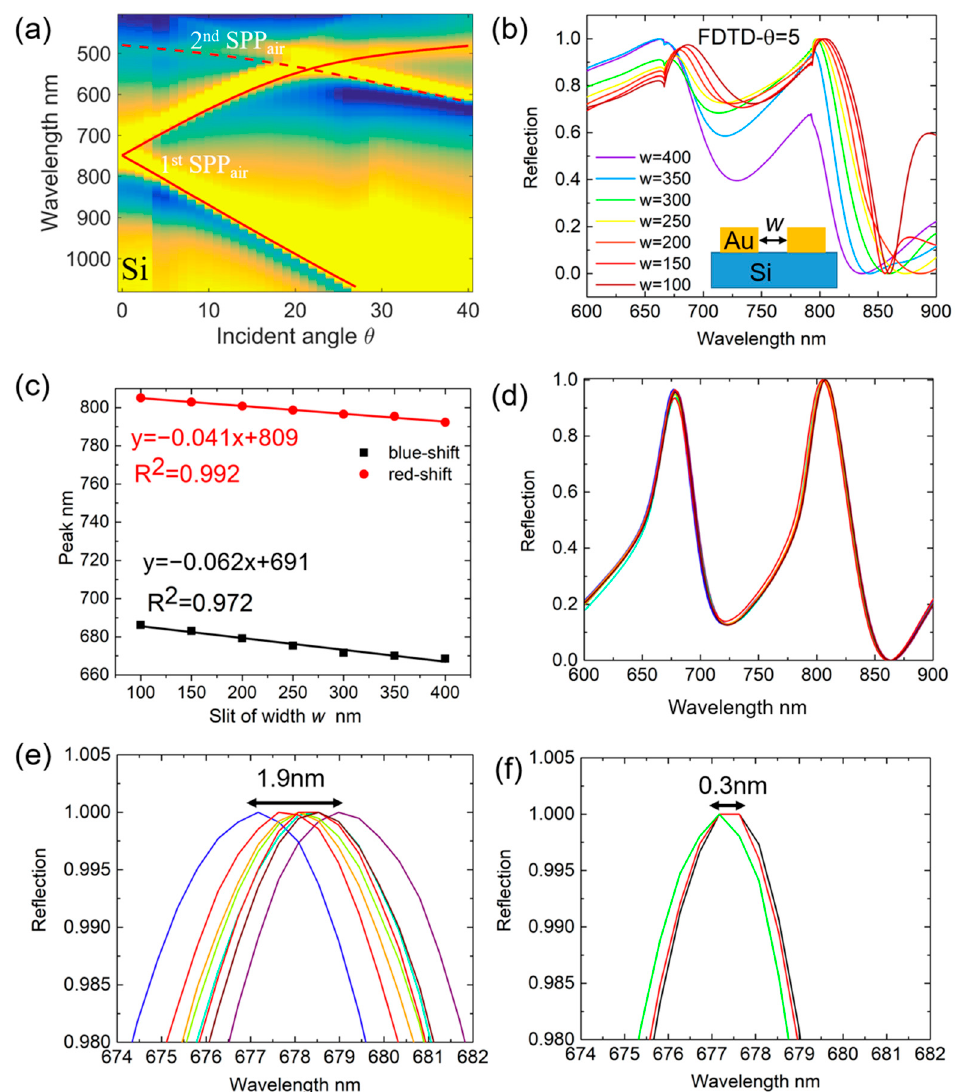
Figure 4. The reflection spectra of gold gratings at different points. ( a ) The reflection spectra on silicon measured with different incident angles. ( b ) The finite-difference time-domain (FDTD) simulation of gold gratings with different width of slit ( w ) on silicon with incident angle of 5°. ( c ) Linear fitting of the position of reflection peak with the width of slit obtained from ( b ). ( d ) The reflection spectra of gold gratings on silicon measured on 8 points on 4-inch silicon wafer. ( e ) The enlarged view of ( e ) at the blue-shift peak. ( f ) The blue-shift peak measured at 3 points on 4 × 4 mm gold gratings on silicon.